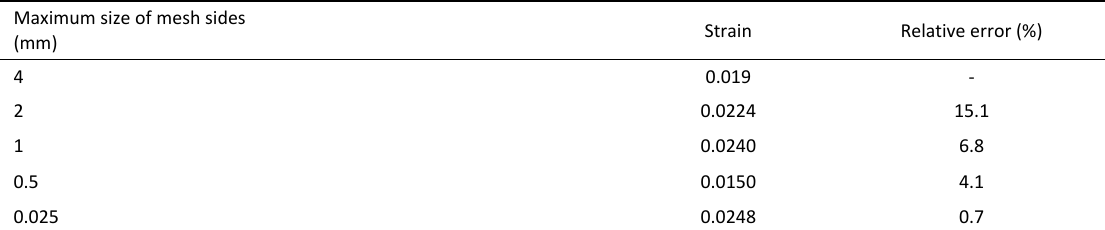
Strain Relative error (%)